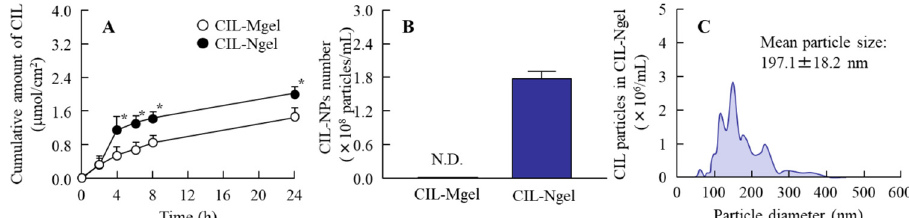
Figure 4. Profiles of CIL release from the gel through 450 nm pore membranes. ( A ) CIL release from